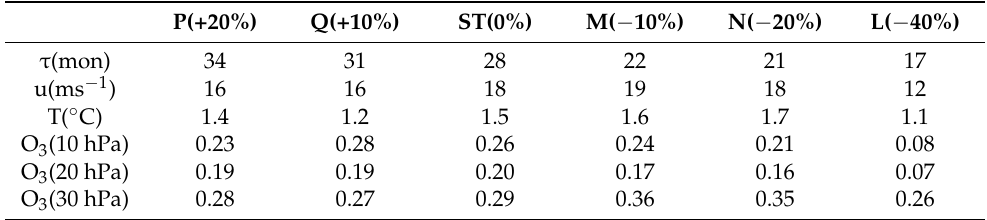
Table 2. Average QBO periods and amplitudes of wind, temperature, and ozone for the six runs. P(+20%) Q(+10%) ST(0%) M( − 10%) N( − 20%) L( − 40%) τ (mon) 34 31